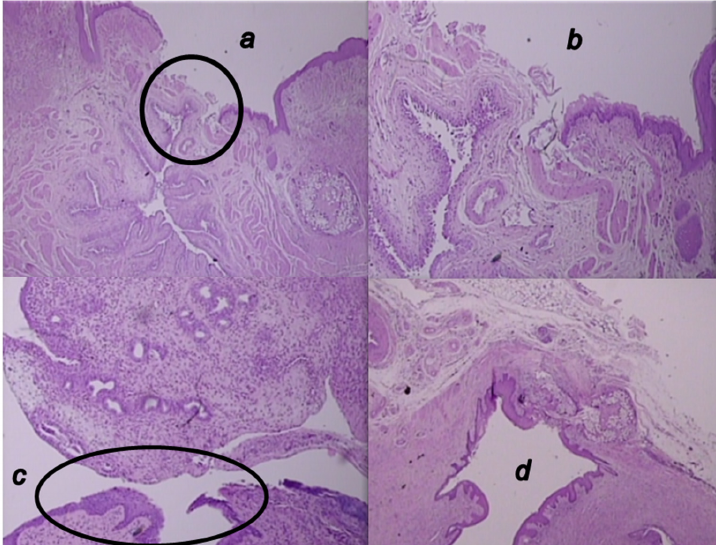
Figure 12. Microscopic presentation of 4 weeks-vesicovaginal fistula, after the two-week therapy of fistulous rats in the BPC 157 treated rats ( a , b ) and control rats ( c , d ). ( a , b ). Visible significant complete epithelialization (circle), collagenization, neovascularization, and formation of granulation tissue in the BPC 157-rats (HE; ×20 ( a ), ×100 ( b )). ( c , d ). Visible open vesicovaginal fistula, tissue defect at the site of the fistula (circle, ( c )) with pronounced inflammation (mononuclear cells and neutrophils), and with significant stromal edema in the controls ( d ) (HE; ×100 ( c ), ×20 ( d )).